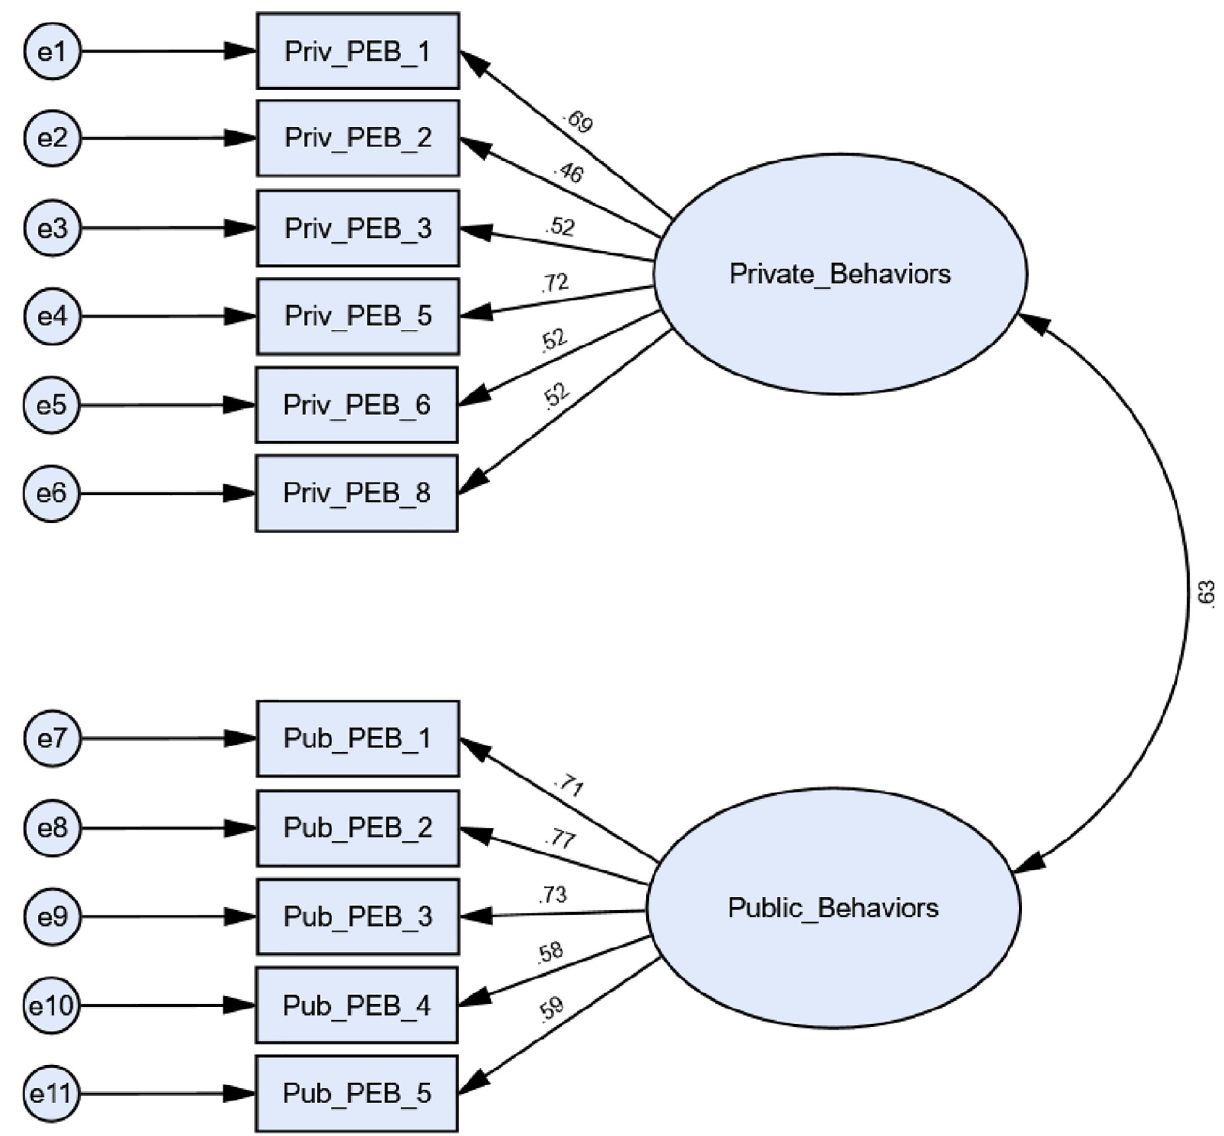
Fig 2. Confirmatory factor analysis diagram for LNT with standardized estimates; global fit indices: S 2 = 415.713, df = 43, p < 0.001; RMSEA = 0.071; SRMR = 0.047; CFI = 0.929.